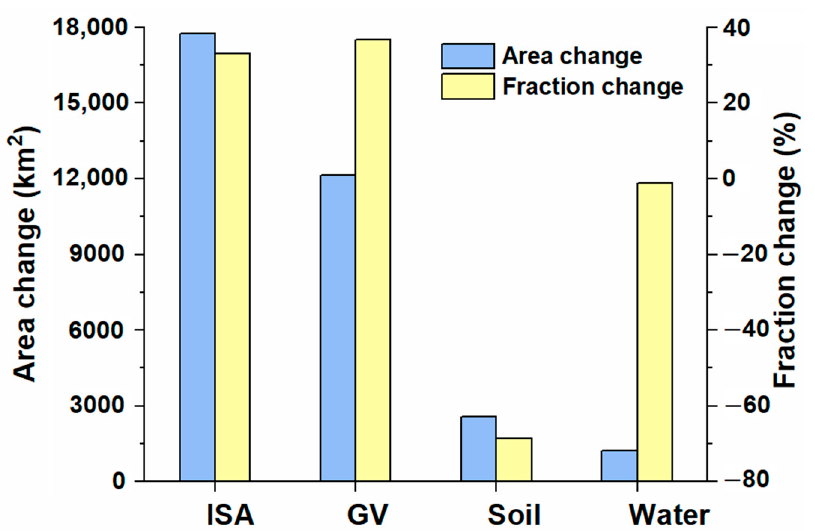
Figure 3. Changes in urban land cover between 1990 and 2015. Abbreviations: ISA: impervious surface area; GV: vegetation.